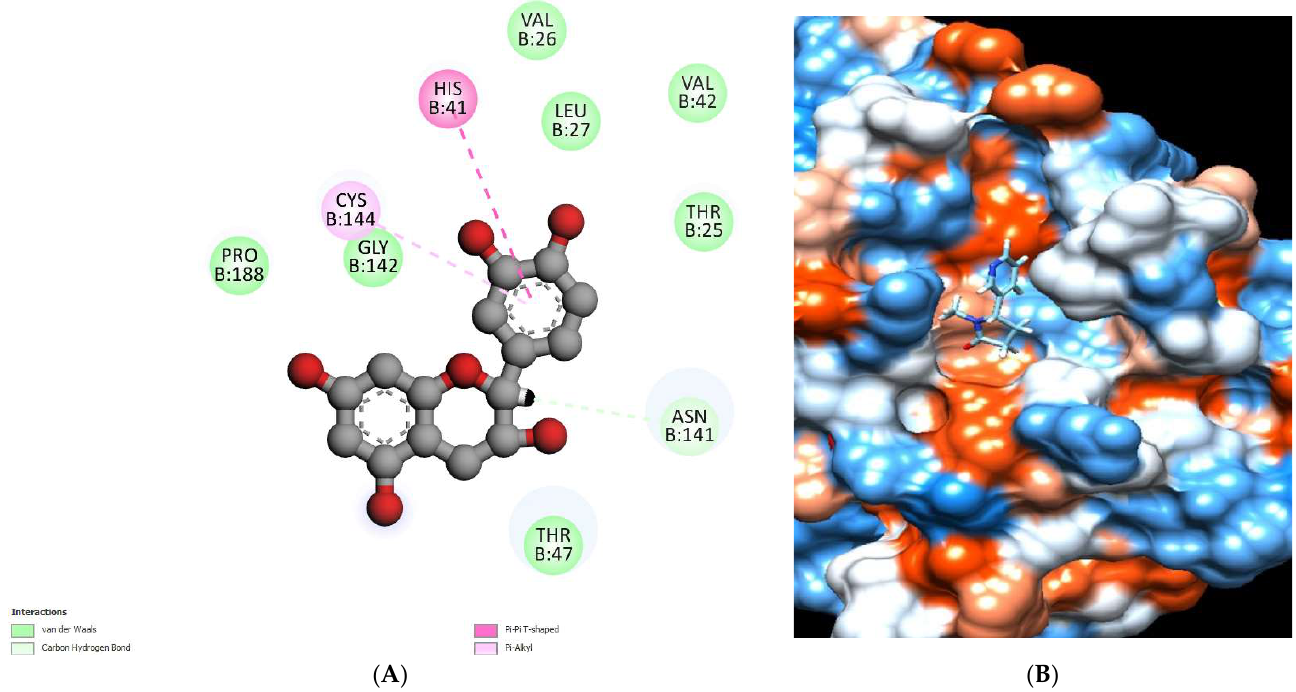
Figure 12. Catechin docked in HCo-V229E main protease, hydrogen bonds (green), and pi interactions are represented in purple lines ( A ), with the mapping surface showing catechin occupying the active pocket of Co-V229E main protease ( B ).